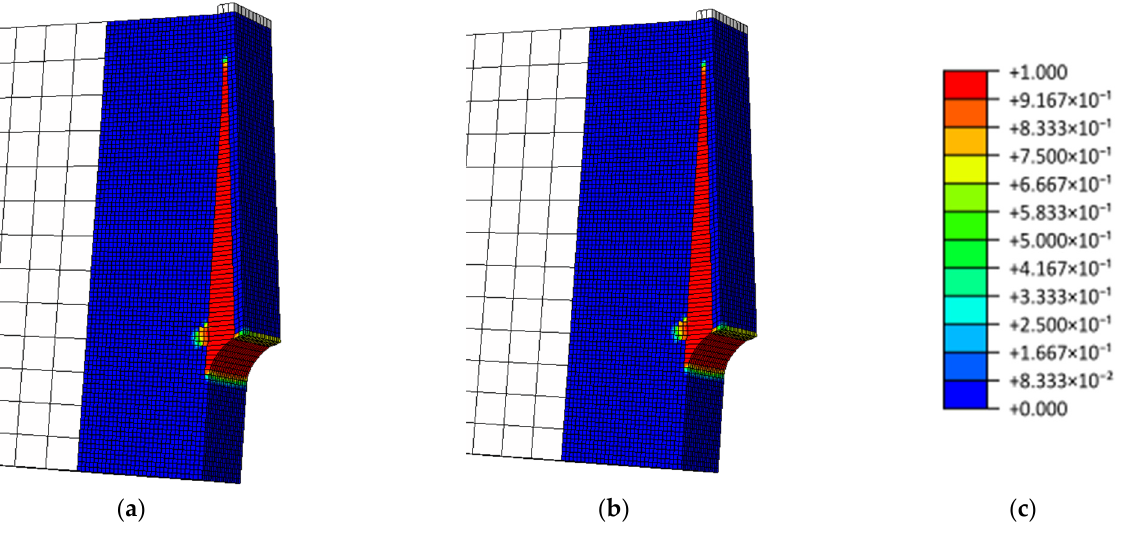
Figure 14. Final tensile matrix damage distribution for ( a ) implicit and ( b ) ITE for the three-point bending test; ( c ) matrix damage scale.